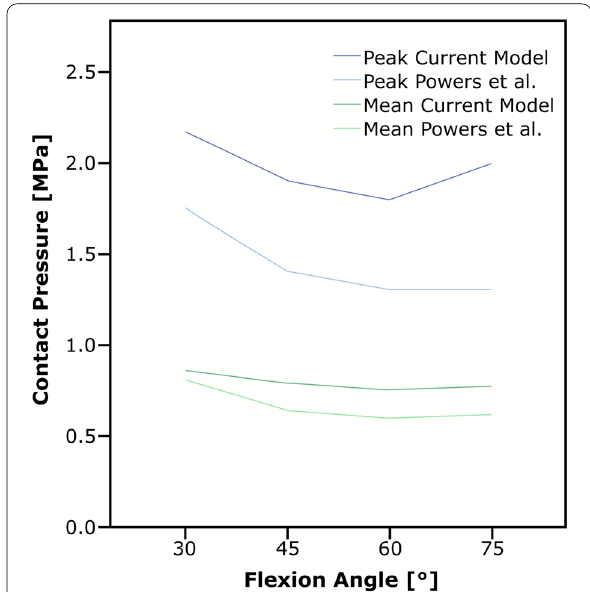
Fig. 7 Peak and mean contact pressure as a function of knee